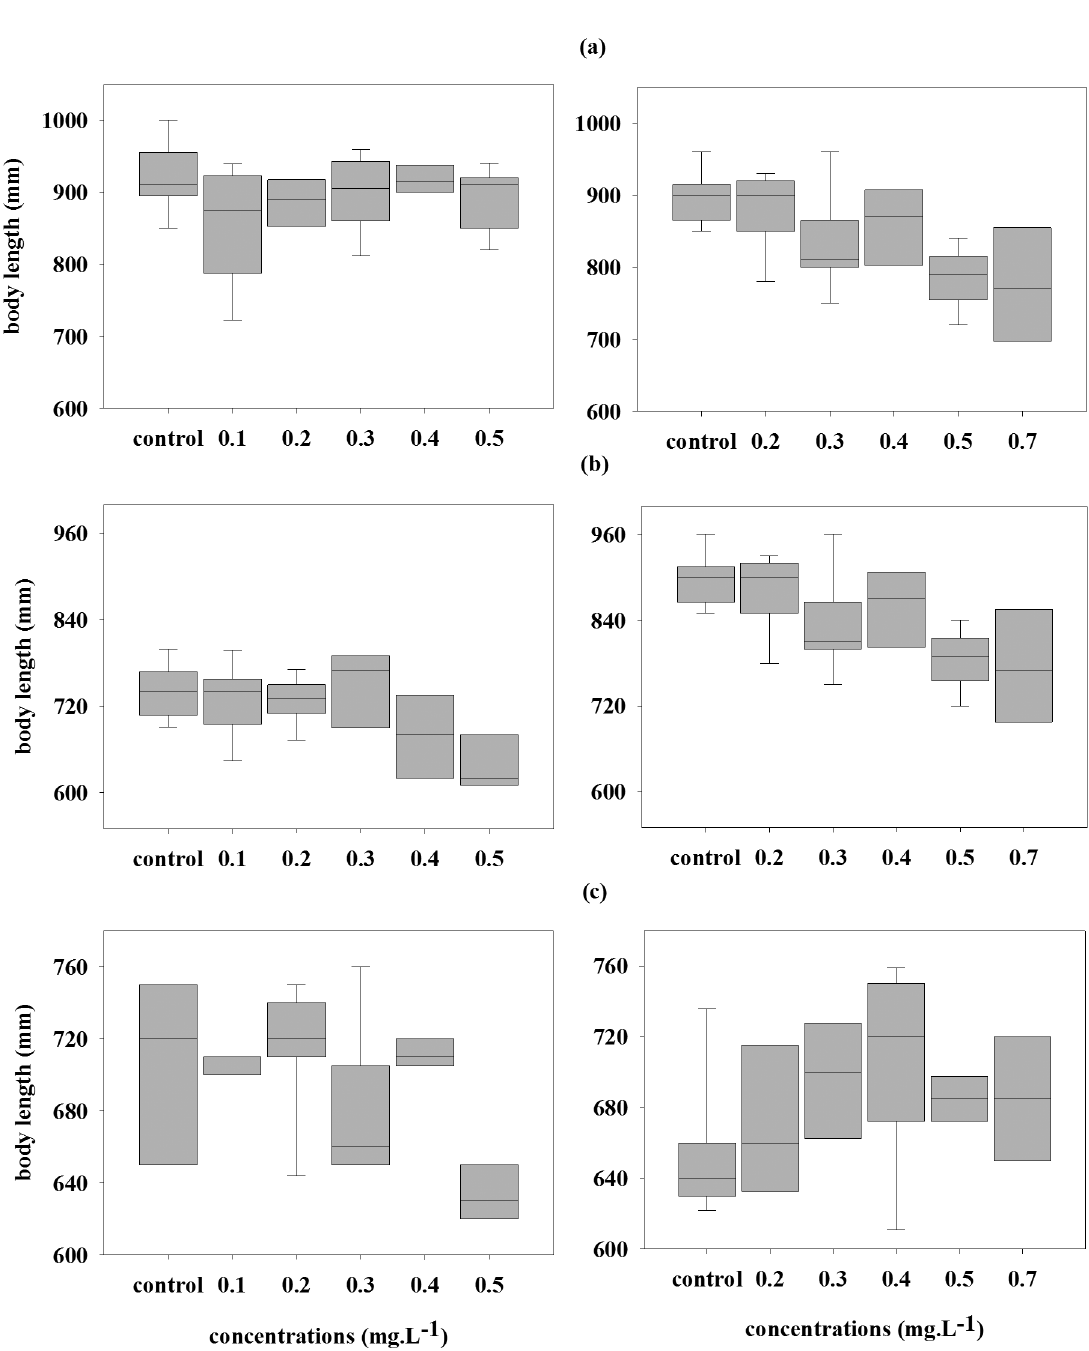
Figure 2 - Body length of adults of C. silvestrii after seven days (a) and neonates after four days maintained in arsenate solutions (b) and in natural water (c) . Test 1 (Left panel) and test 2 (right